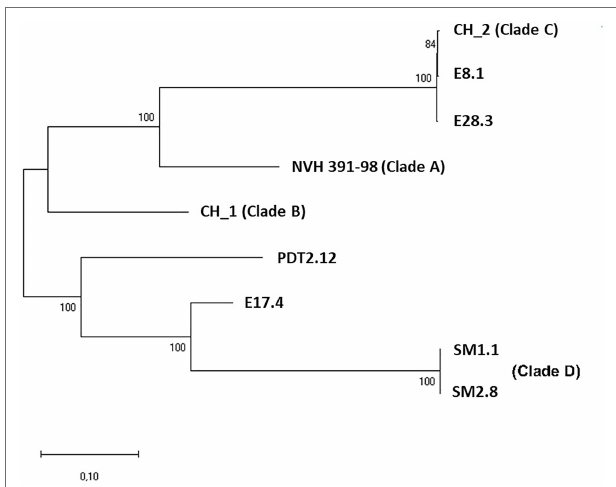
FIGURE 2 | Maximum Likelihood single nucleotide polymorphism (SNP) base-phylogenetic tree of the six sequenced B. cytotoxicus strains, along